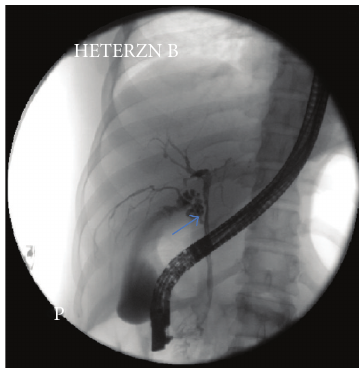
Figure 3: Endoscopic retrograde cholangiopancreatography (ERCP) demonstrating aberrant right hepatic duct draining a segment of right lobe of liver and emptying into cystic duct ( arrow ).